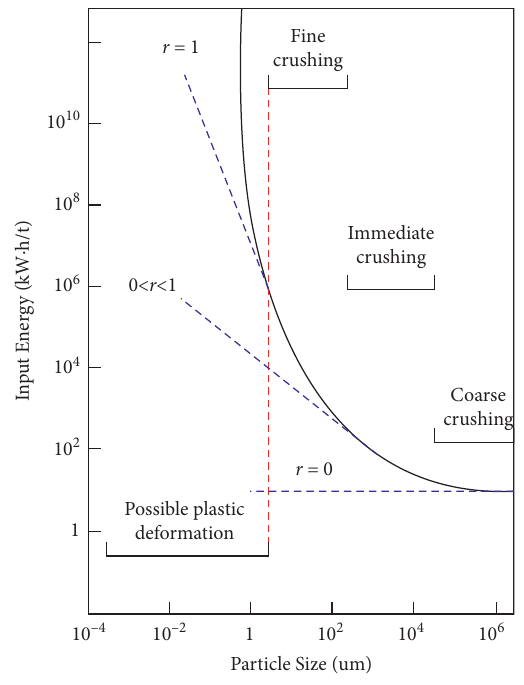
Figure 4: Energy-particle size